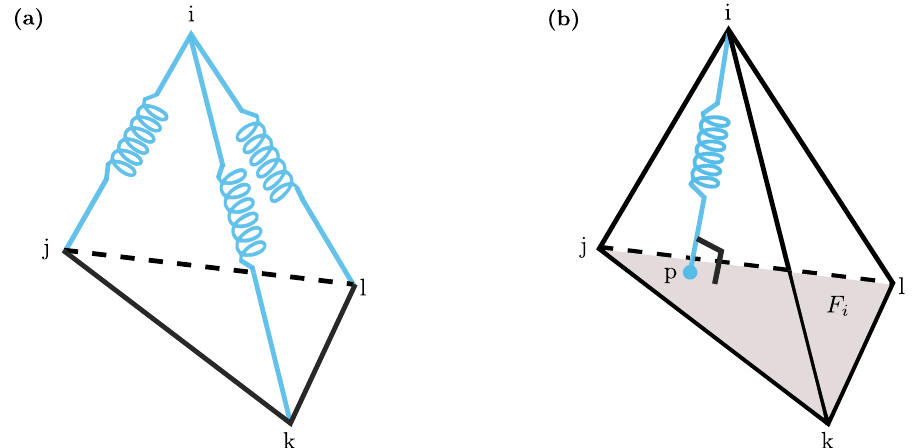
Figure 4. Visual representation of fictitious springs used to compute the mesh velocity. In particular, the edge-node springs and vertex-ball spring associated with i -th node are depicted in ( a ) and ( b ),